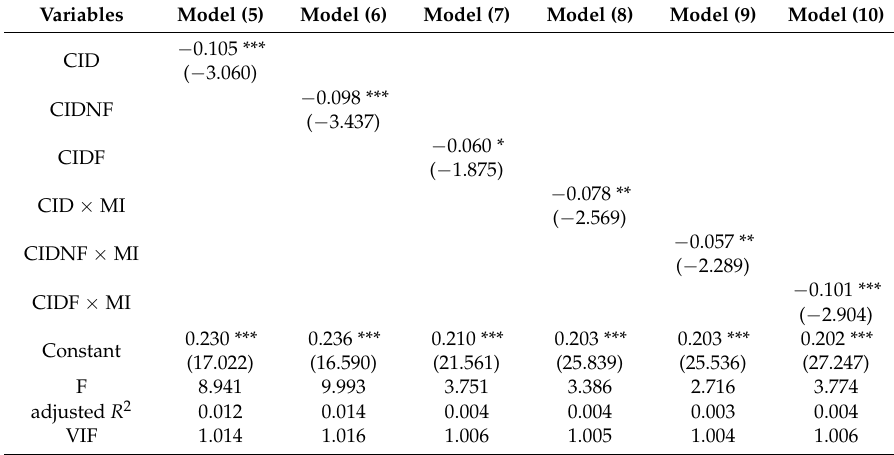
Table 3. Regression analysis of marketization degree, carbon information disclosure and cost of equity